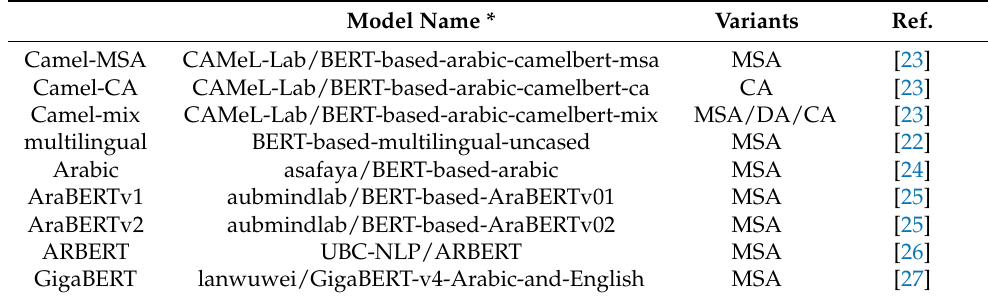
Table 2. Pre-trained language